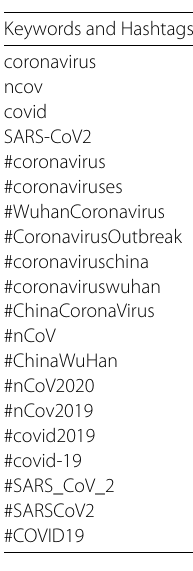
Table 1 Keywords and Hashtags which drove the data collection phase Keywords and